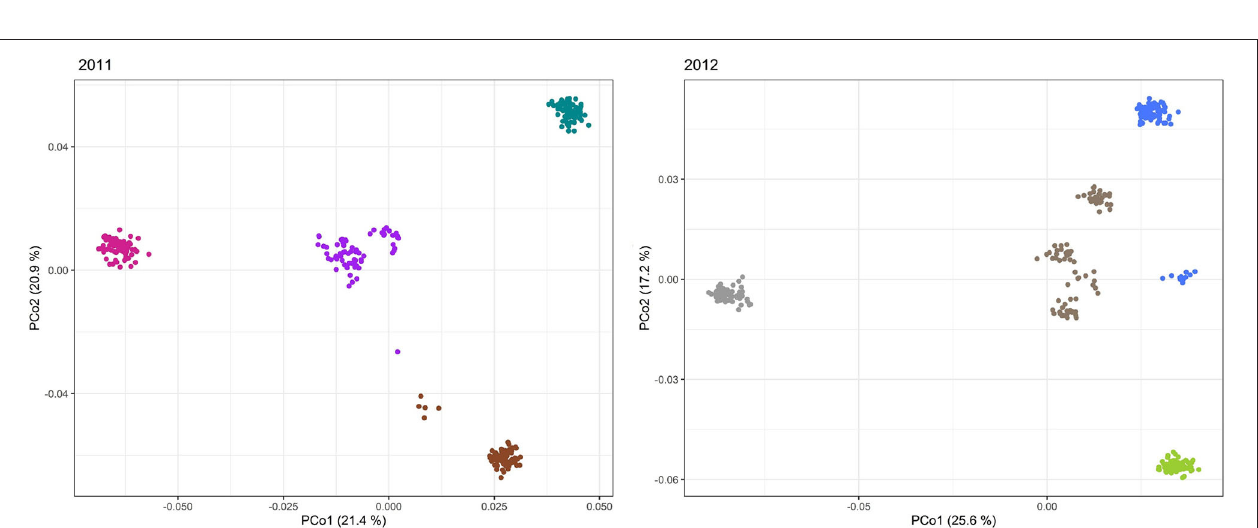
cyclin and the transmembrane ABC transporter STAR2 ( Supplementary Table 5 ). Major effects (R 2 > 10%) on TAX and WAX in 2011 were observed for 17 and 23 SNPs,